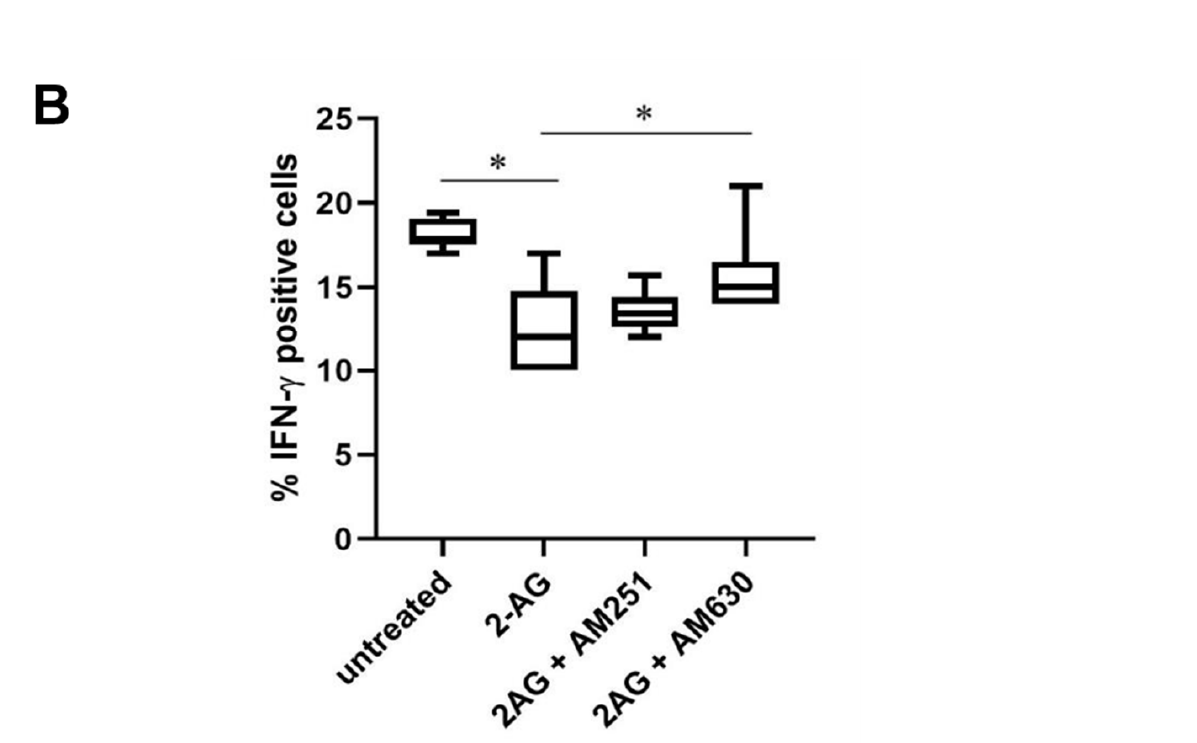
Figure 3. Effect of CB 1/2 antagonists on Th1 lymphocytes expressing IFN- ɣ in SLE patients. ( A ) Experimental design. PBMCs isolated from 6 SLE patients were pretreated for 30 min with selective antagonists of CB 1 and CB 2 receptors, AM251 and AM630, respectively (200 nM). Then, 2-AG (1 μ M) was added to the culture and cells were analyzed by flow cytometry as previously described. ( B ) Flow cytometry analysis of the percentage of Th1 lymphocytes expressing IFN- ɣ after treatment with AM251 and AM630 CB antagonists and 2-AG in SLE patients ( n = 6). * p < 0.05.